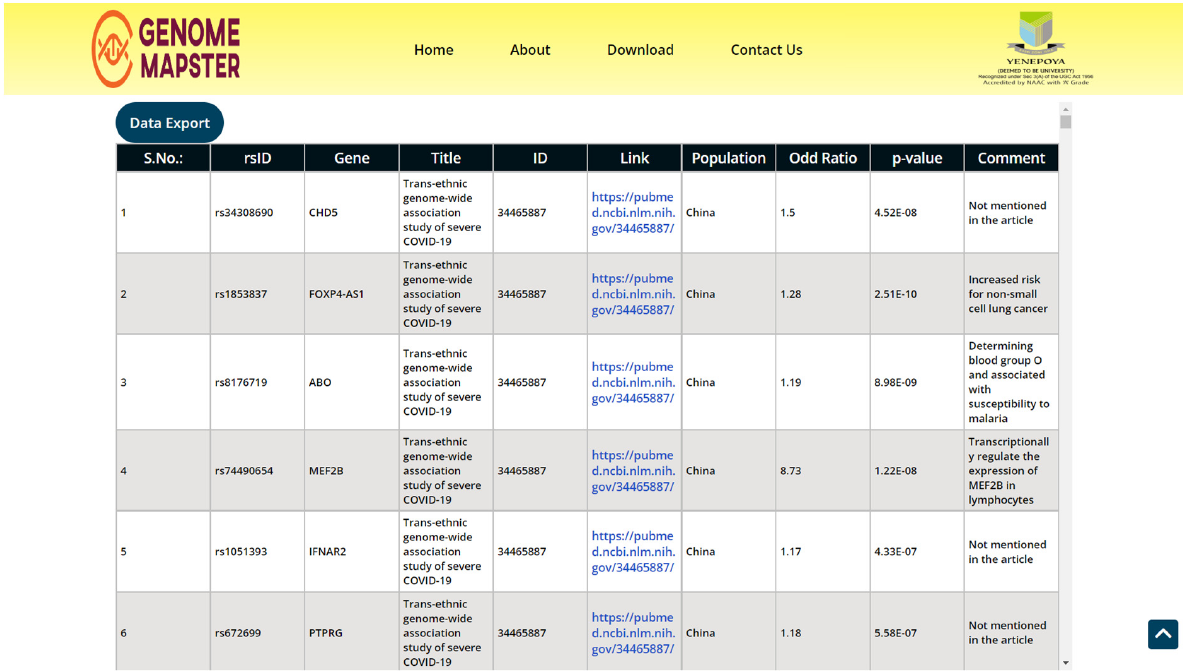
Figure 4. Snapshot of the download page containing ten fields in table format. This page gives detailed information on host-specific genetic variants (reference single nucleotide polymorphism cluster ID/chromosome position) and genes involved in COVID-19, and other relevant information such as a serial number, title, ID, link, population, odd ratio, p -value, and comment.